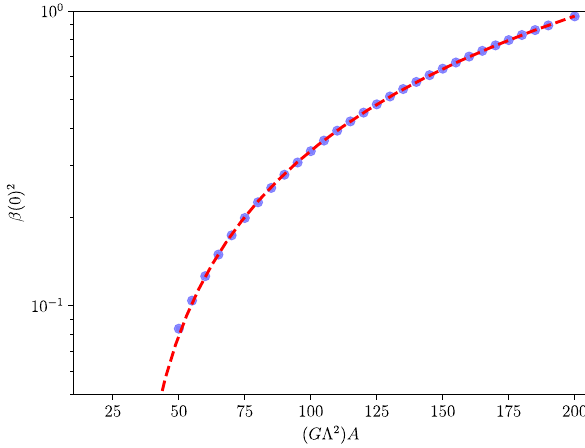
Fig. 4 β 2 ( 0 ) as a function of ( G Λ 2 ) A where A and B . We take A = B with G Λ 2 = 1 and vary the values of A . The blue dots are the solutions to the SDE and the red dotted line is the fitted polynomial